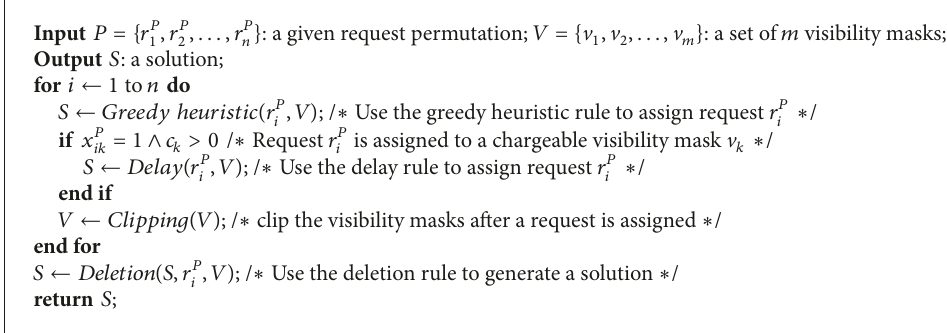
Algorithm 1: The schedule generation algorithm.